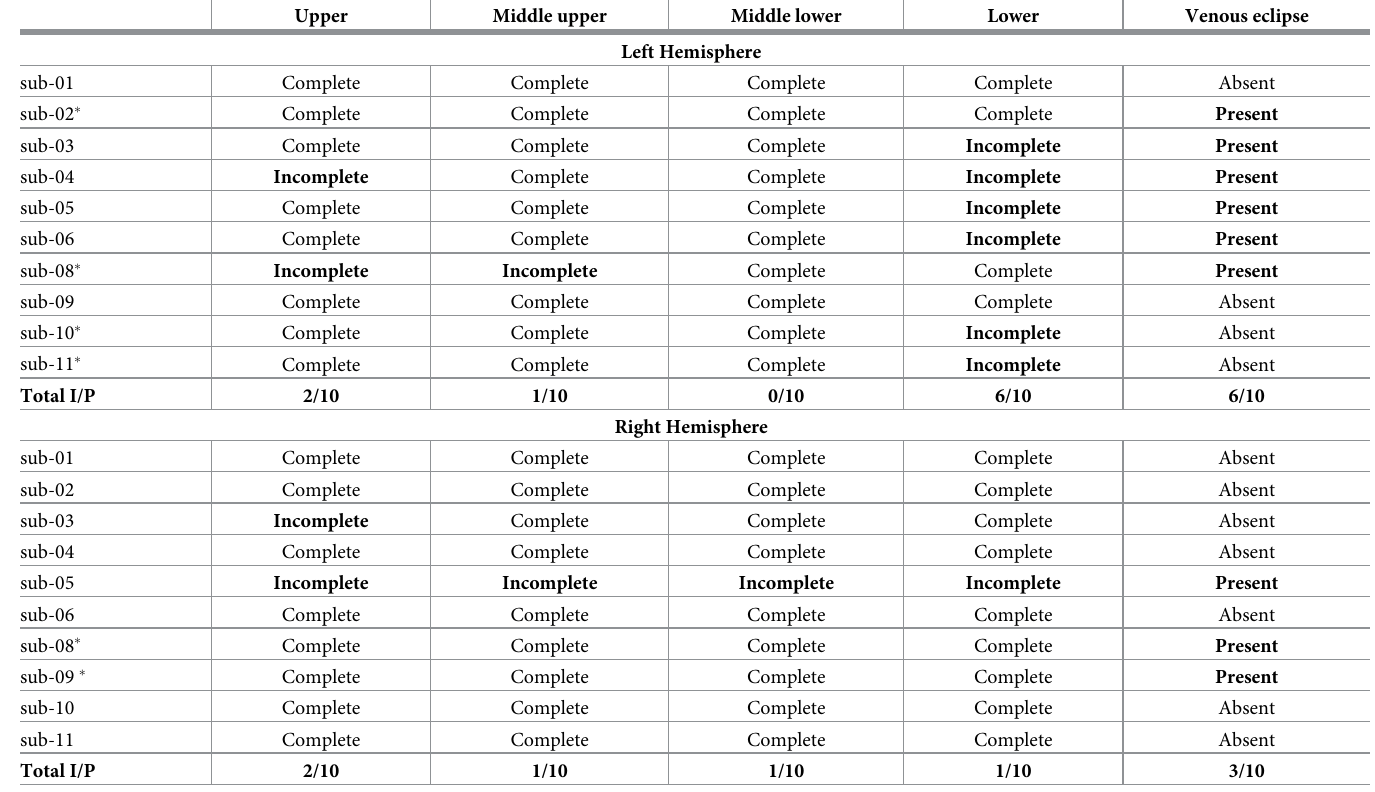
Table 1. hV4 visual field coverage of each hemifield quadrant and venous eclipse presence in or near hV4.